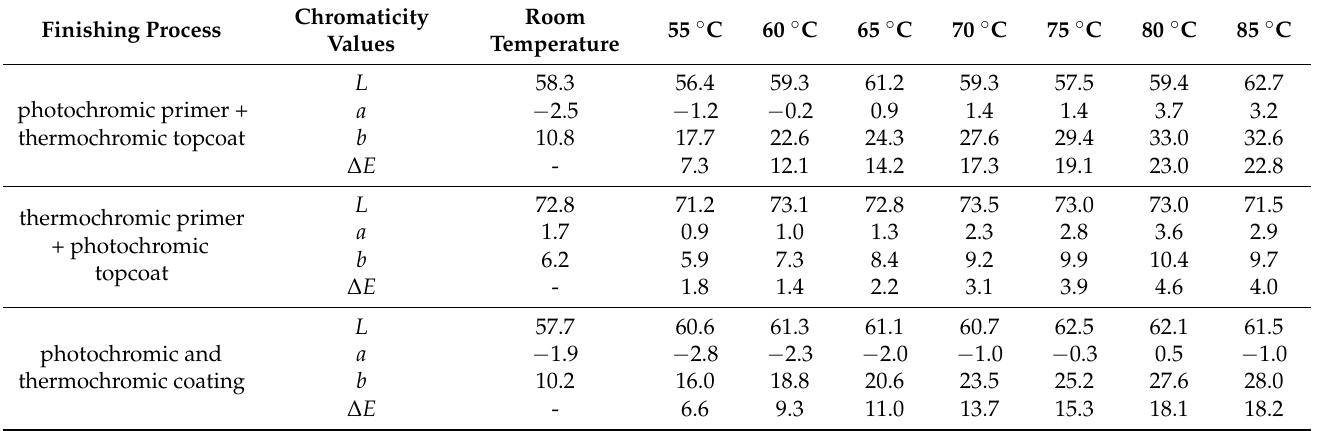
Table 2. Chromaticity values of the film under different finishing sequences during the heating pro- cess.